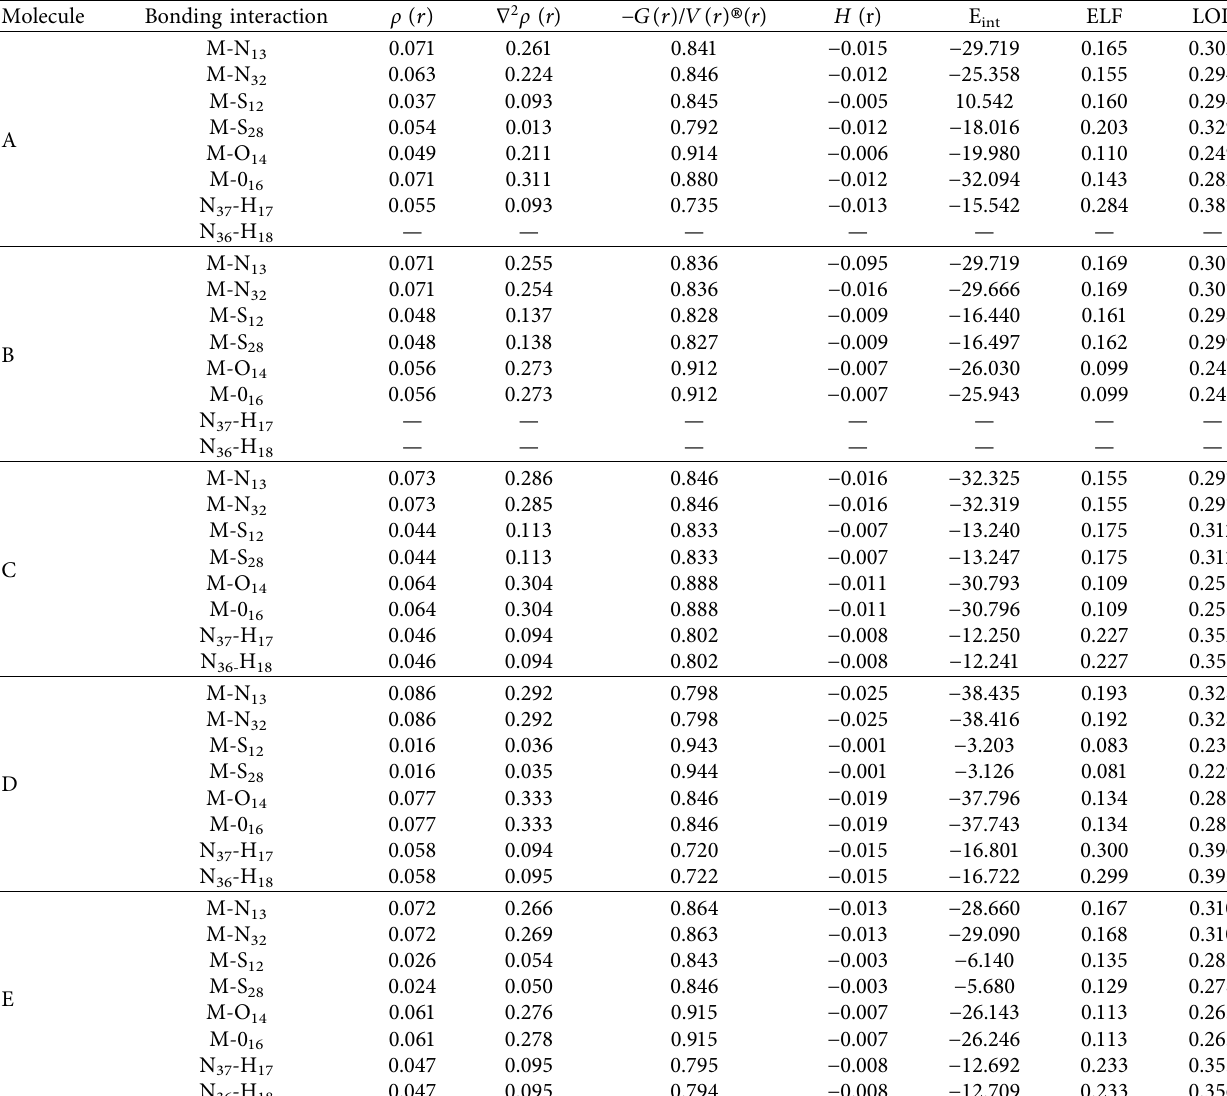
Table 3: Computed values of ρ ( r )/a.u, Laplacian of electron density ∇ 2 ρ ( r )/a.u, ratio G ( r ) / V ( r ) , energy density H Kcalmol − 1 , ELF, and LOL in a.u. Molecule Bonding